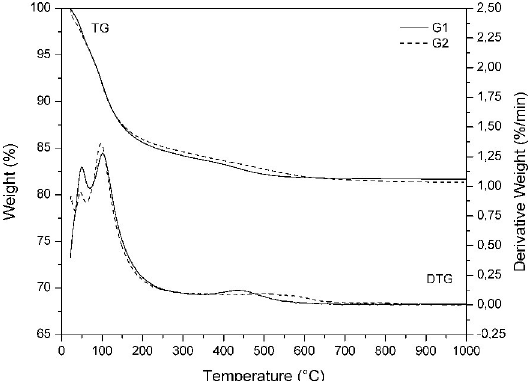
Figure 7. TGA curves of G1 and